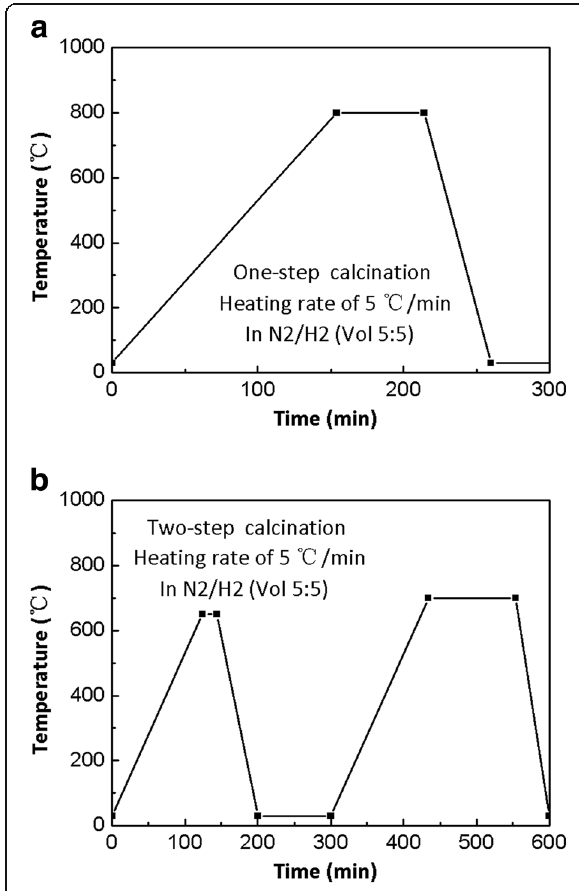
Fig. 5 The two different reduction calcination processes of